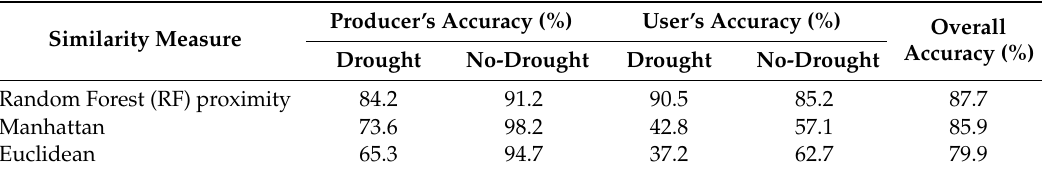
Table 1. Accuracy assessments for different similarity measures (drought stressed ( n = 57) and non-stressed ( n = 57)).